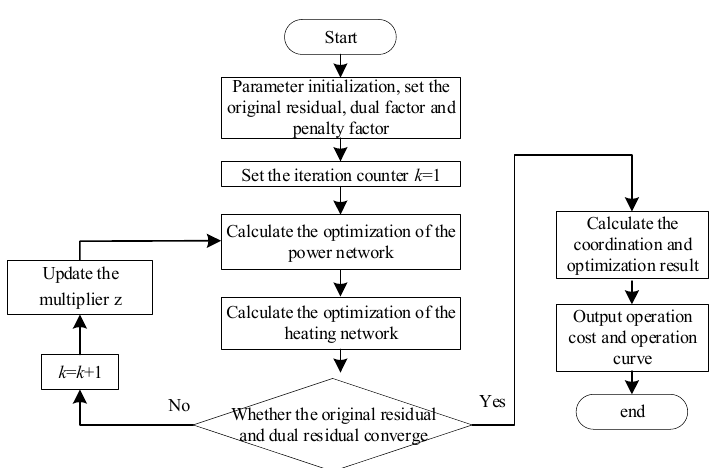
Figure 2. Flow chart of a solving multi-energy coordination problem based on the alternating direction multiplier algorithm.